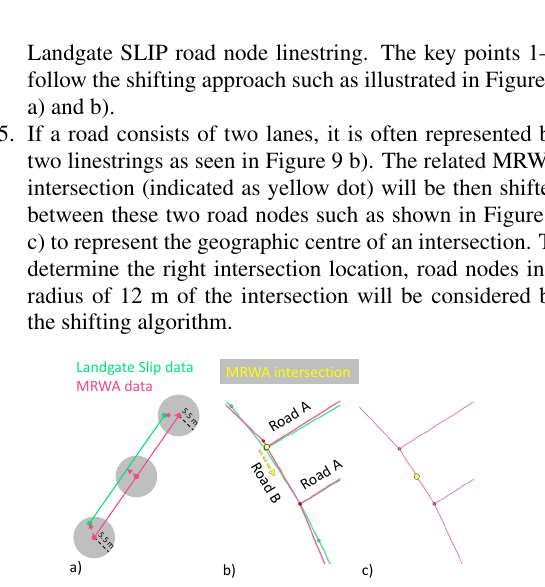
Figure 9. The shifting condition of MRWA geographic point coordinates is that a Landgate SLIP geographic point or line must be a) within 5 meters as indicated. If a road has two lanes as in b), then the related intersection will be shifted to the centre of the intersection as in